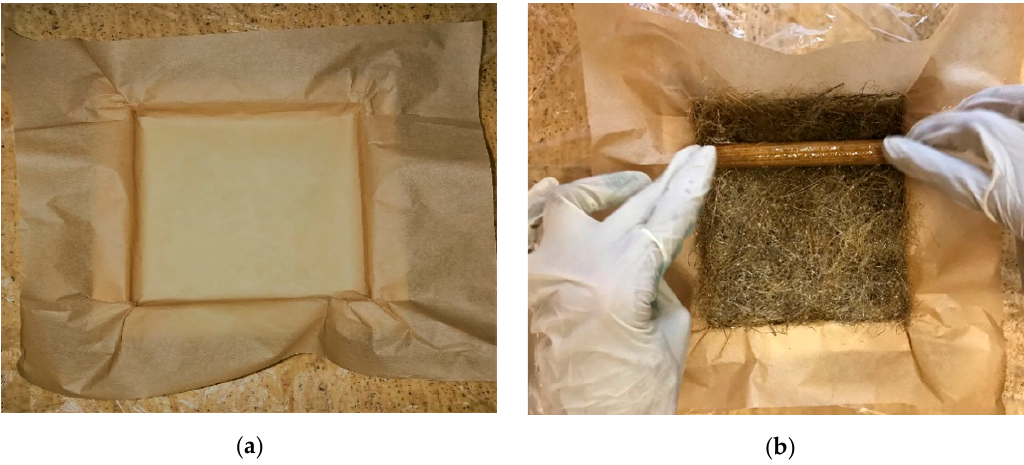
Figure 2. Mold material for fabrication purpose ( a ); roller on the composite surface ( b ).